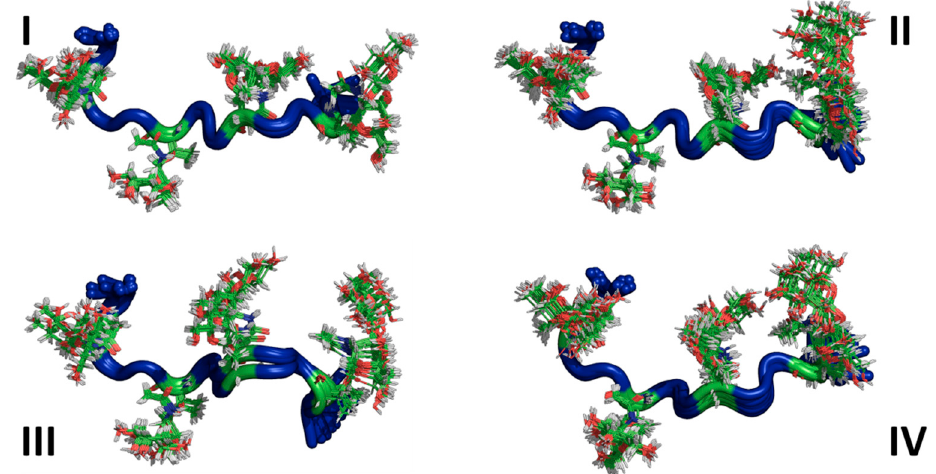
Figure 4. Clusters of sub-states in the representative ensemble NMR structures of AFGP8-TB. The top 4 clusters of the representative NMR structures of the total 128 structures. The structures are represented as cartoons, with the glycosylated threonine residues shown in lines. The number of structures in each cluster is Cluster I = 17, Cluster II = 17, Cluster III = 16, and Cluster IV = 14.